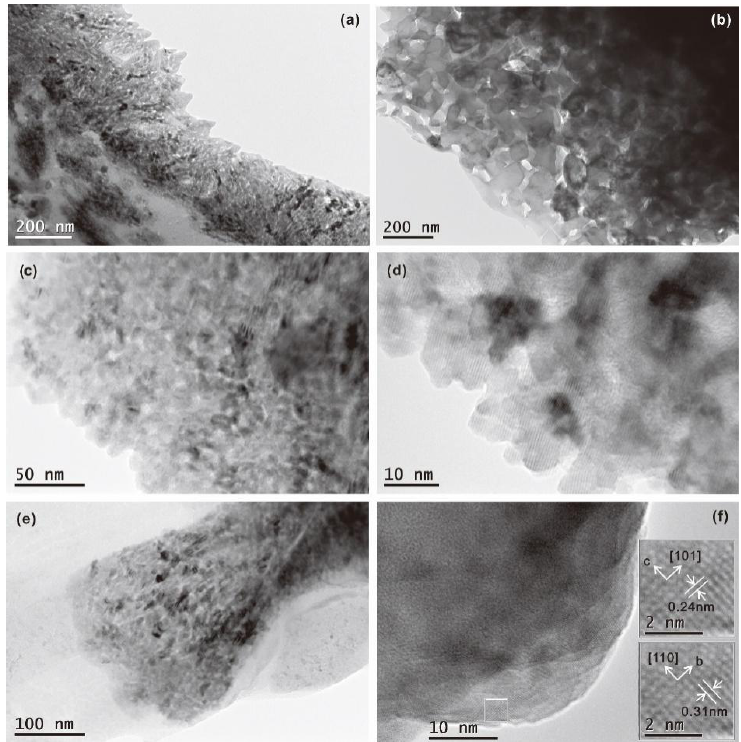
Figure 6. TEM and HRTEM images of Mn oxide ore in the Xialei deposit. ( a – d ): Pyrolusite in sample XLO-2. ( e , f ): Pyrolusite in sample XLO-1. ( f ) Two-dimensional Fourier-filtered lattice image.